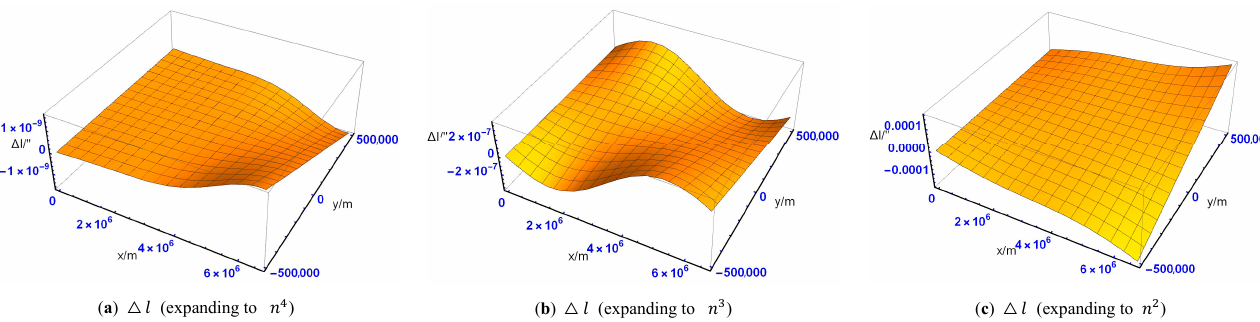
Figure 11. The distribution of the longitude truncation difference △ 𝑙 when expanding to 𝑛 (cid:2872) , 𝑛 (cid:2871) , and 𝑛 (cid:2870) .